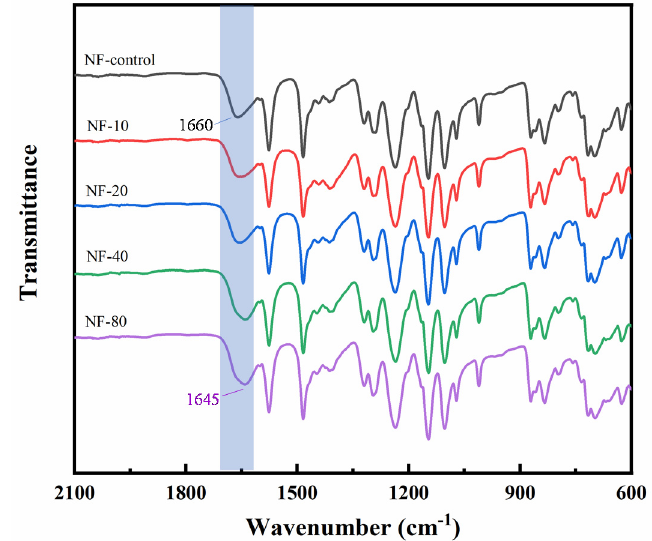
Figure 6. ATR-FTIR spectra of the thin-film composite NF with different concentrations CaCl 2 added in the post-treatment.